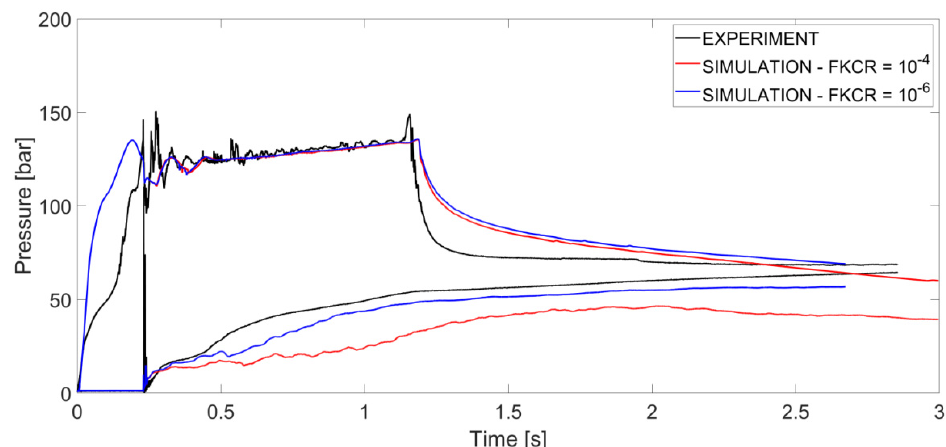
Figure 16. Coupled simulation—pressure evolution in the injection line and in S1B, compared with experimental data at different reaction rates.